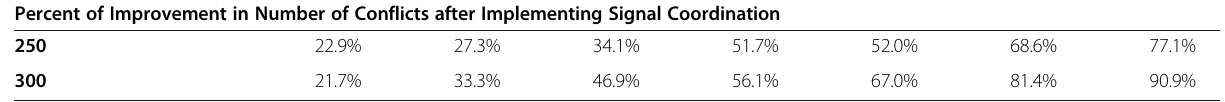
Table 2 Comparison of Simulated Number of Conflicts between Coordinated Signal Plans and Free Signal Operation Scheme at North McCarran Blvd (Continued)